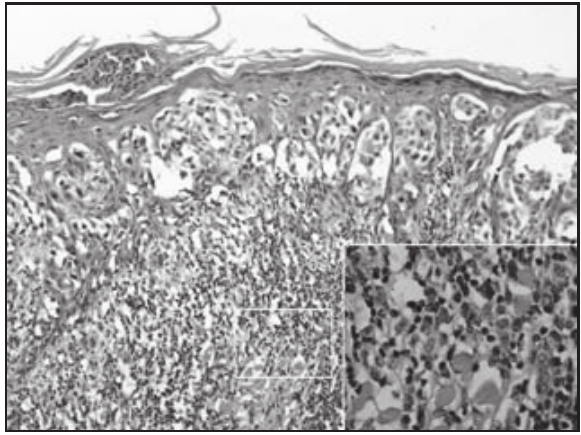
Figura 1 – Melanoma in situ com regressão na fase inicial caracterizado por denso infiltrado inflamatório obscurecendo a periferia do tumor e contendo corpos apoptóticos (no detalhe). Caso 35, HE, 100x (aumento original) HE: hematoxilina e eosina.